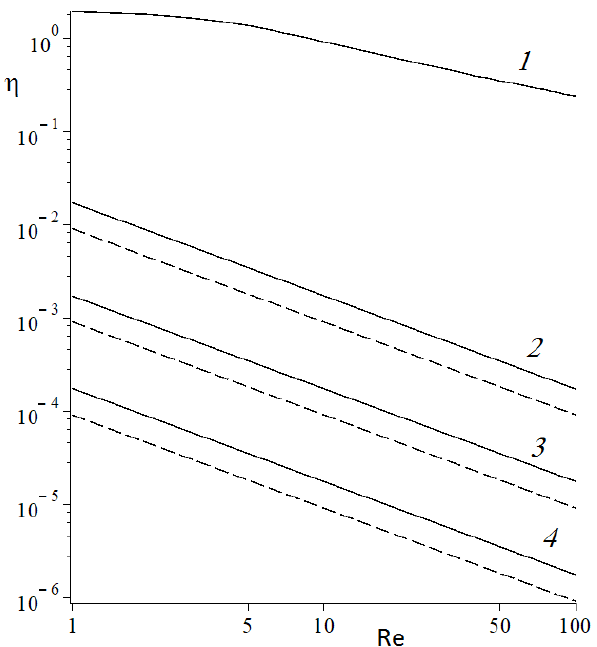
Figure 5. Retention efficiencies of profiled hollow fibers with parallel grooves (solid lines) and smooth circular hollow fibers with the same outer radius (dotted lines) on the Reynolds number: pairs of curves 1 — 𝐾 = 0 (solid and dotted curves merge), 2 — 𝐾 = 0.1, 3 — 𝐾 = 1, 4 — 𝐾 = 10; Sc = 1.